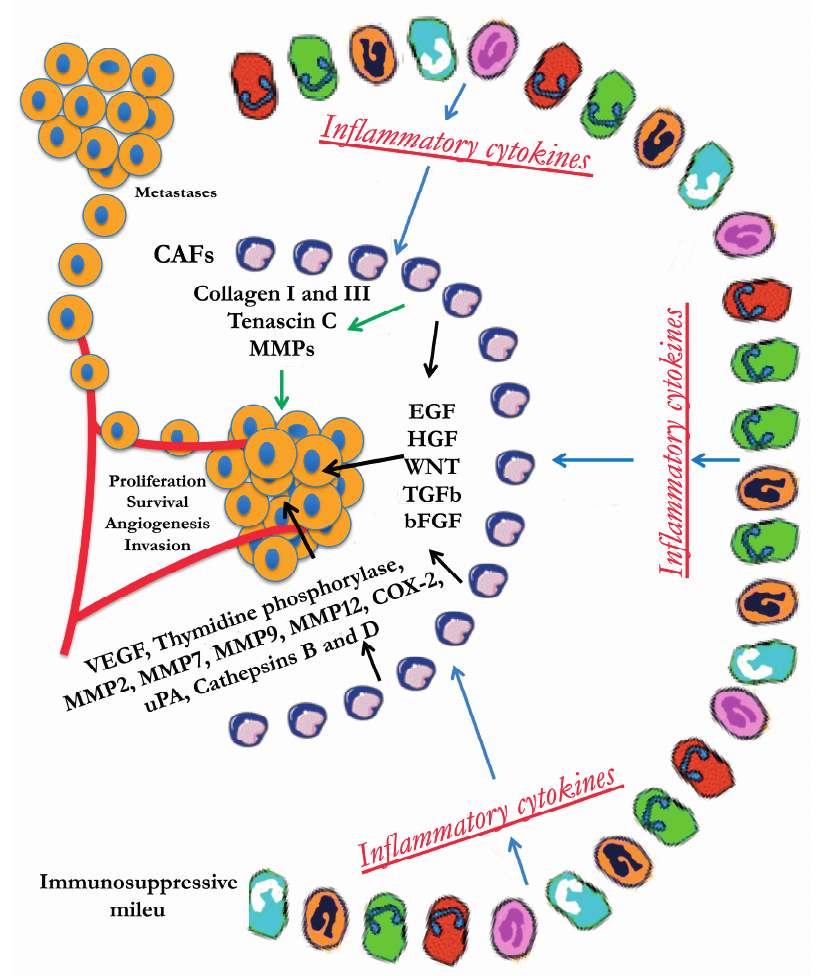
Figure 3. Invasive and metastatic signaling from the tumor